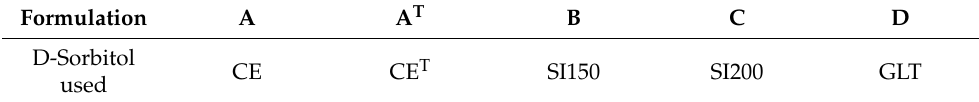
Table 2. Summary of D-Sorbitol used for the preparation of formulation A, A T , B, C and D.